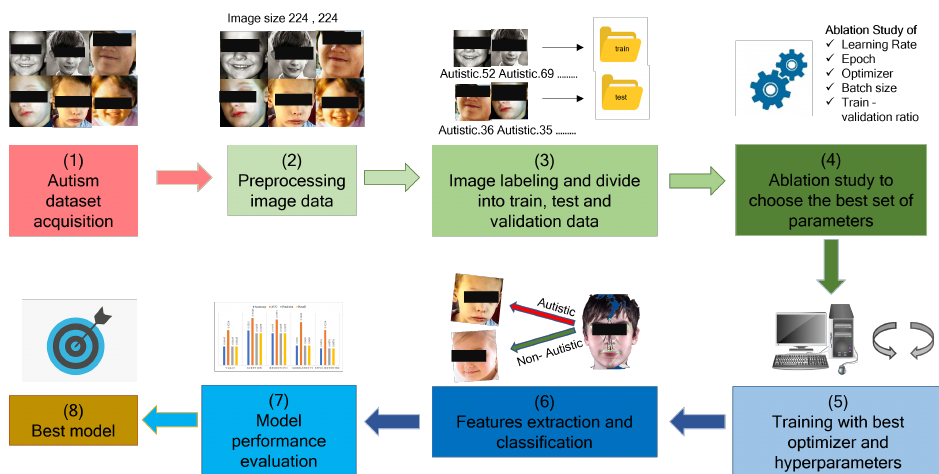
Figure 2. Proposed framework of the transfer learning approaches used in this study.